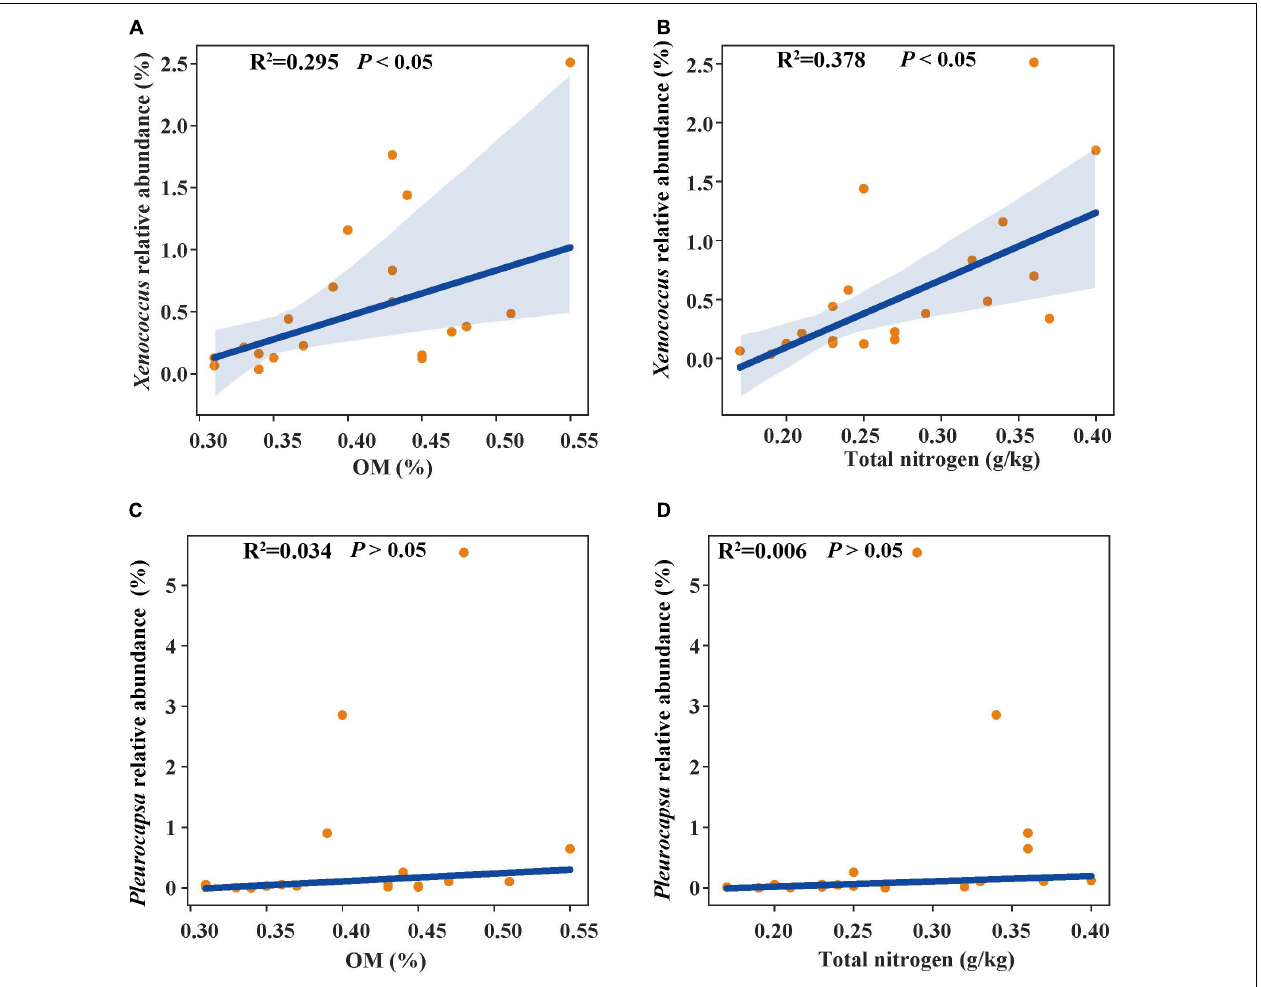
FIGURE 5 | Linear regression relationship between organic matter (A) , total nitrogen (B) and Xenococcus relative abundance; organic matter (C) , total nitrogen (D) and Pleurocapsa relative abundance.